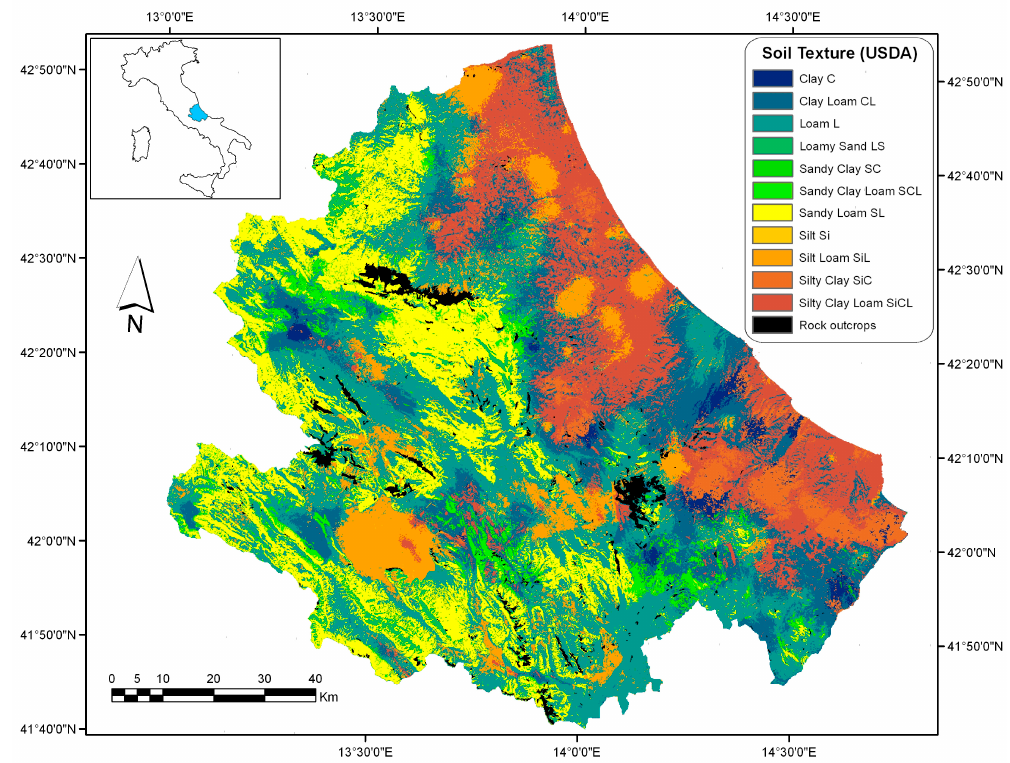
Figure 4. Soil texture predicted by RK (USDA).